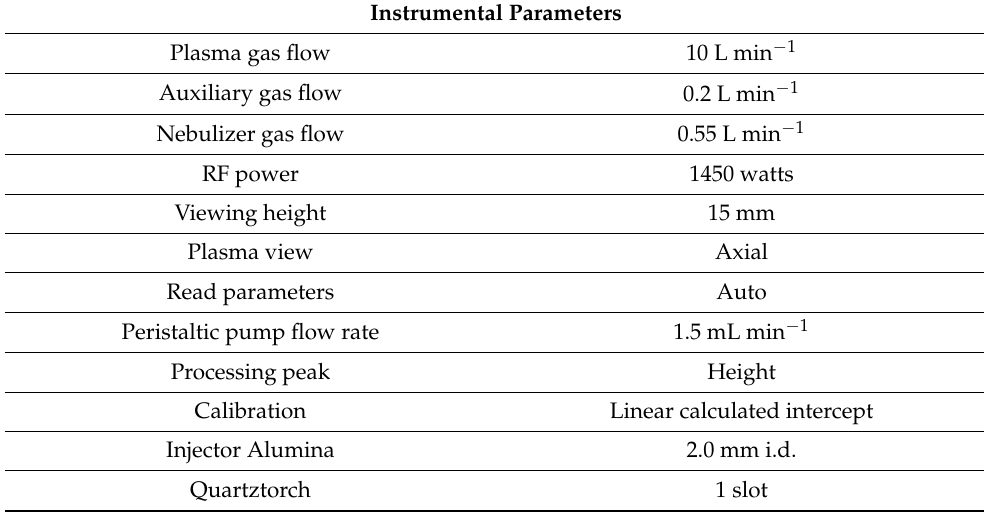
Table 1. Operative conditions of ICP–OES.